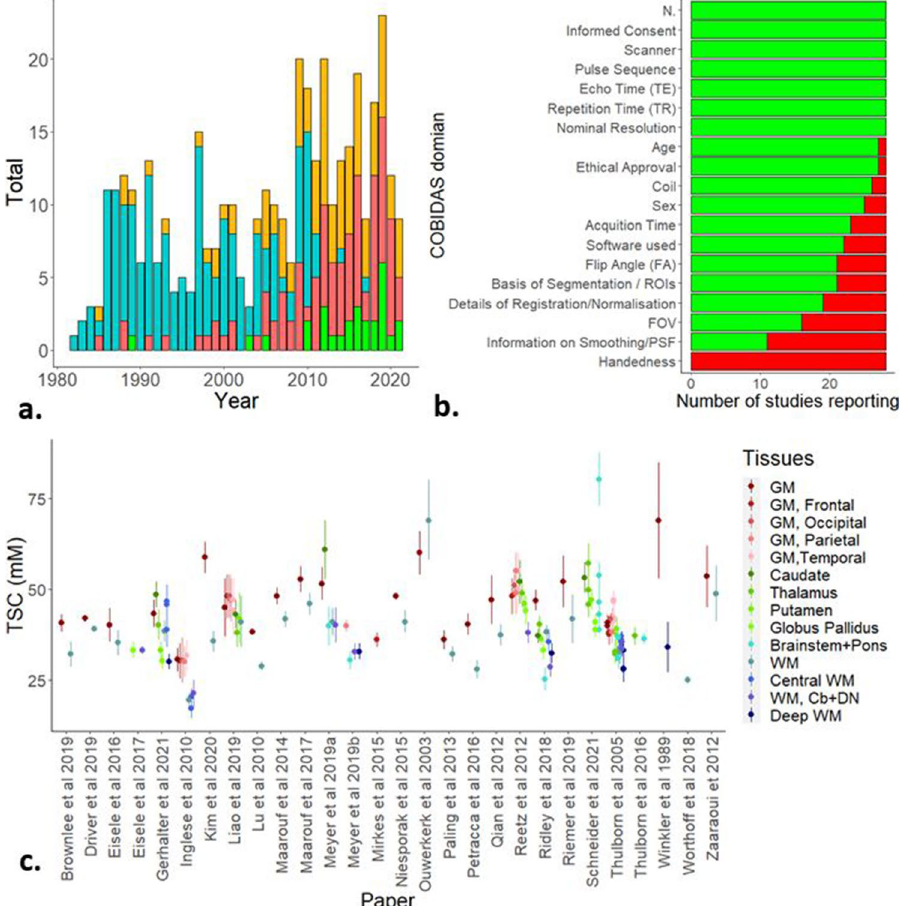
Figure 3. Descriptive plots for identified and included studies. ( a ) Literature search results 1980–2021 by year of publication. Chart includes total papers published for a given year (orange), publications identified by searching bibliographies (cyan), papers identified through the MEDLINE search (red) and number of studies included (green). ( b ) Overview of COBIDAS Domains reported in included studies. FOV, Field of view; PSF, Point spread function; ROIs, regions of interest. ( c ) Scatterplot of 141 effect sizes used in meta-analysis by published report in alphabetical order of first author surname. Error bars correspond to standard deviation, except for Zaaraoui et al. 2012 who reported range and Driver et al. 2019 who reported standard error. Cb cerebellum, DN dentate nucleus, GM grey matter, WM white matter. Images created in R 84–86